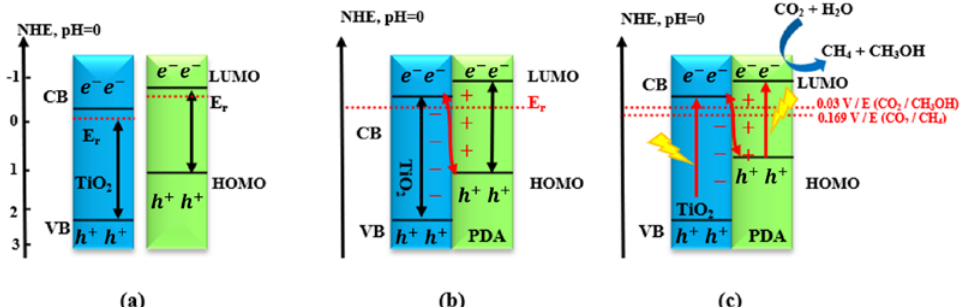
Figure 20. Schematic illustration of the relative band energy positions of TiO 2 and PDA before contact ( a ), after contact ( b ), and under irradiation ( c ), and the S-scheme charge transfer mechanism between TiO 2 and PDA under irradiation.